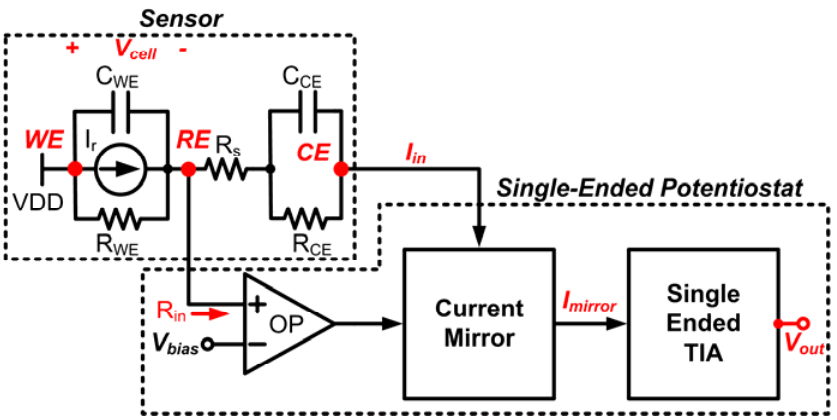
Figure 3. The building blocks of single-ended potentiostat.